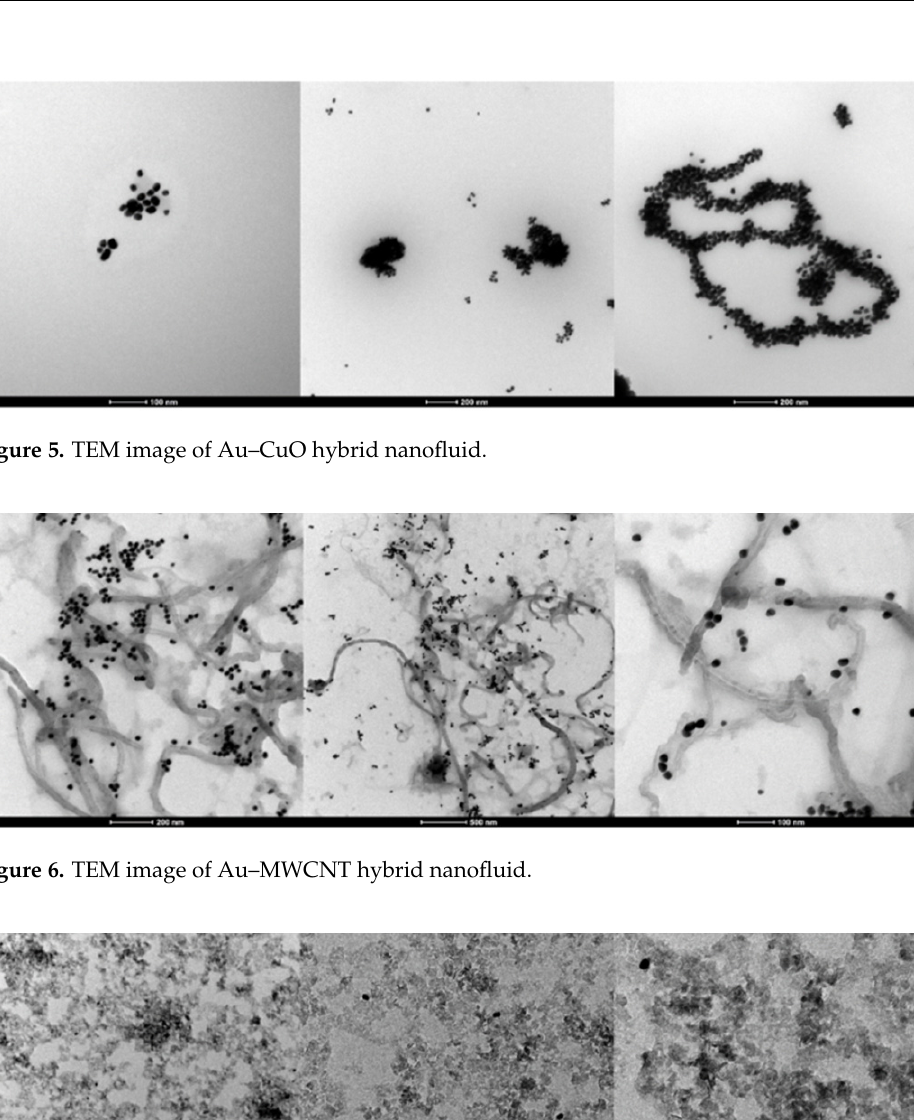
Figure 4. TEM image of Au − Ag hybrid nanofluid.